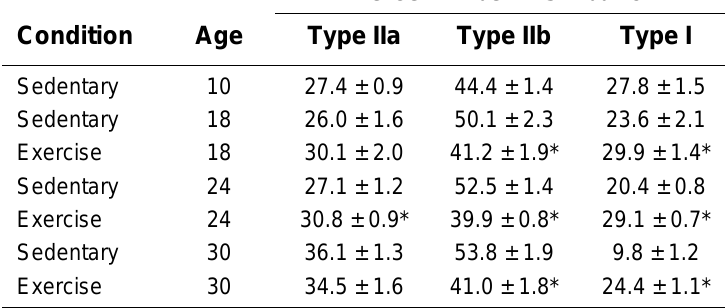
Effect of Exercise on Plantaris Muscle Fiber Distribution of